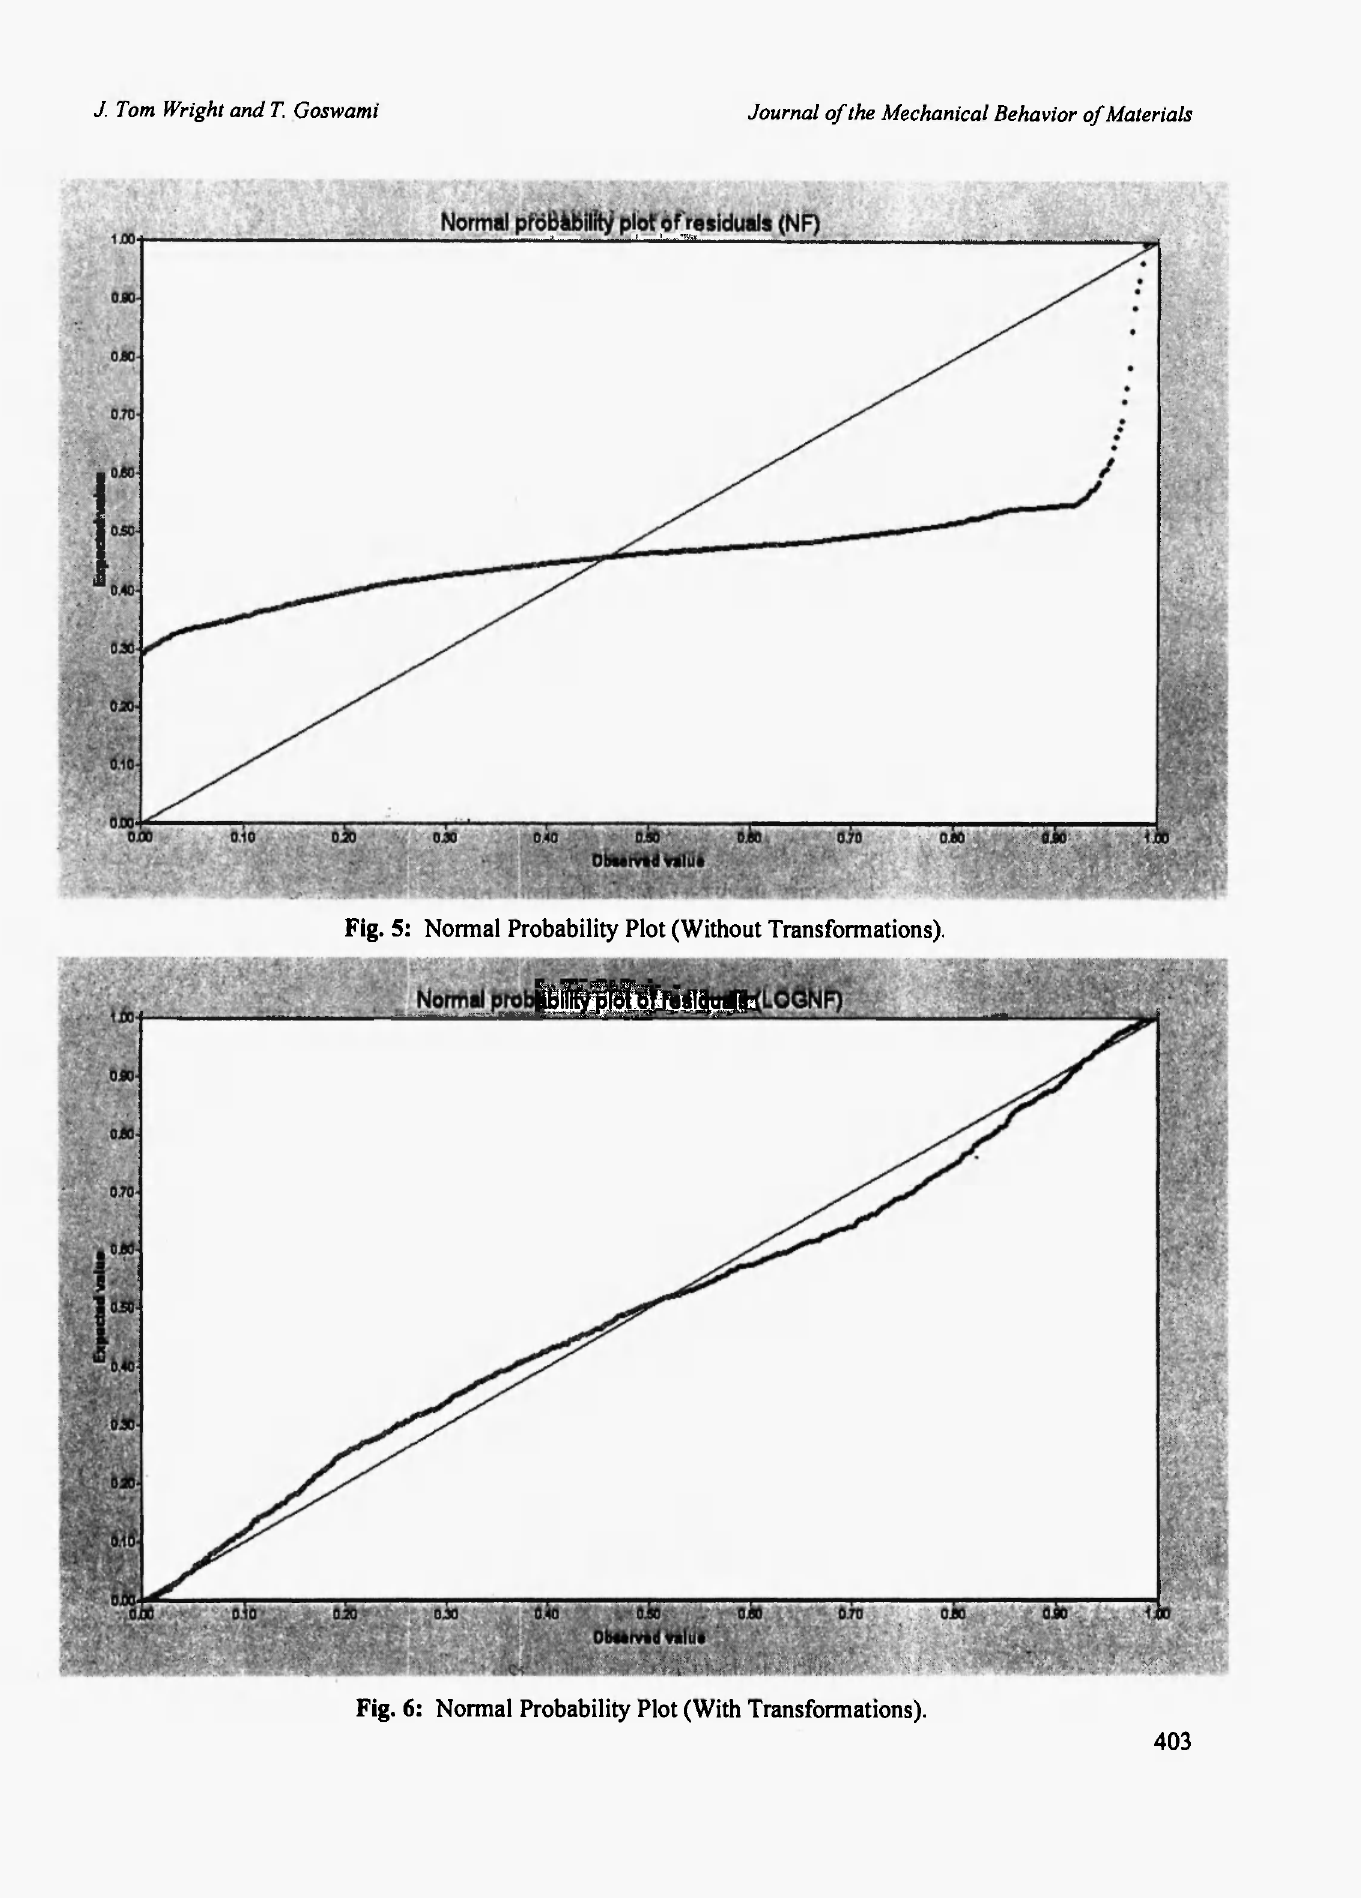
Fig. 5: Normal Probability Plot (Without Transformations).